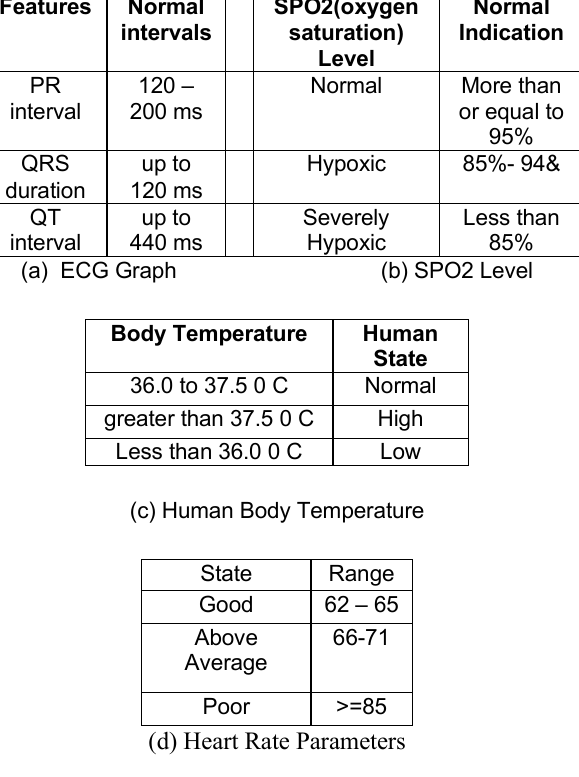
Table 2. Standard Health